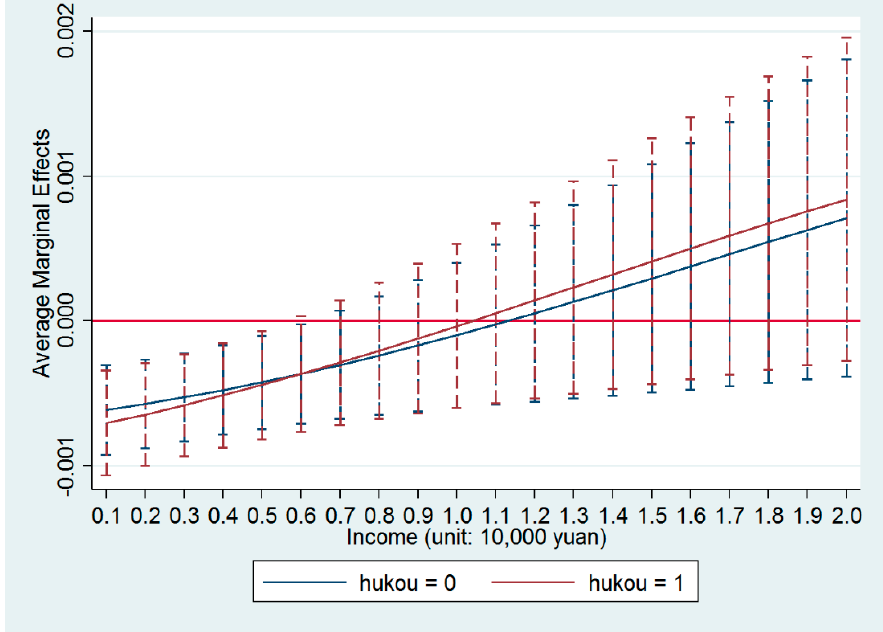
Figure 2. Average marginal effects of PM2.5 with 90% confidence intervals for the migrants of different “hukous.”